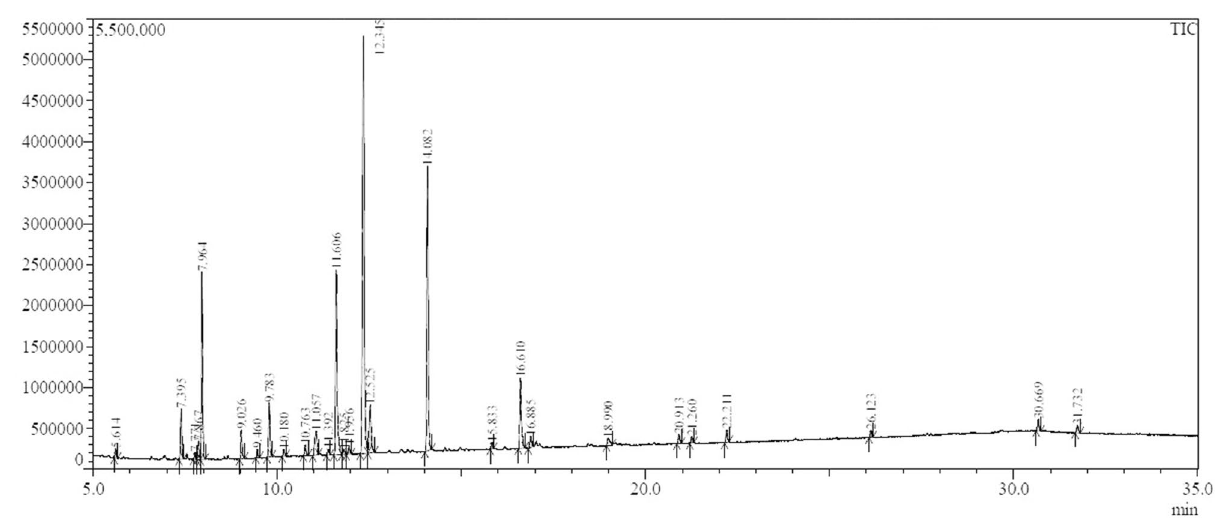
Figure 4. GC–MS chromatogram showing the chemical composition of lavender essential